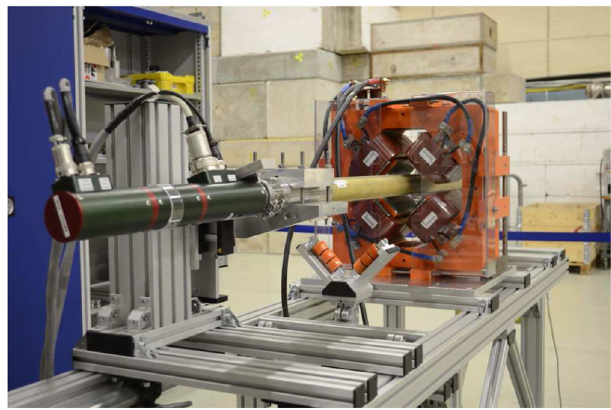
FIG. 12. Picture of quadrupole prototype during magnetic